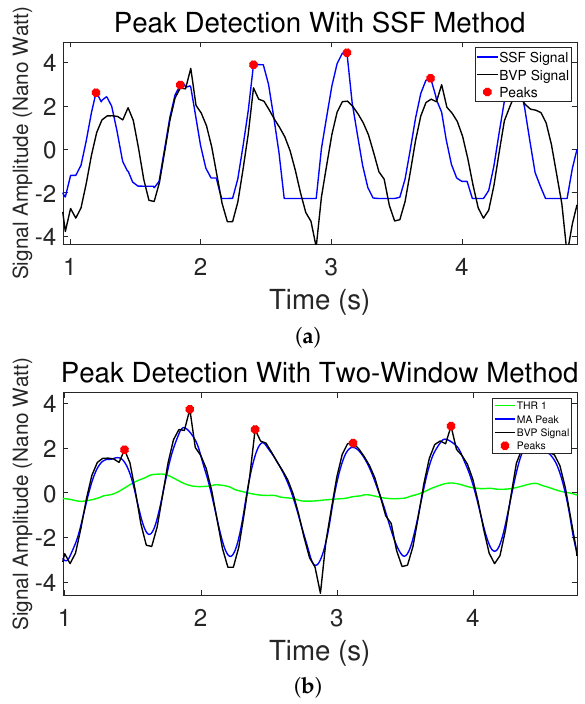
Figure 6. ( a ) SSF in peak detection. ( b ) Two-Window method in peak